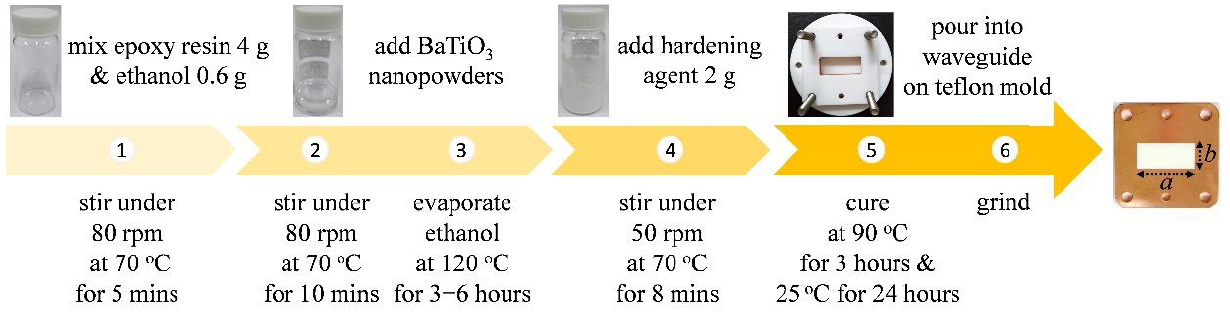
Figure 1. Flow chart for sample preparation. Detailed processes are described in the main text.